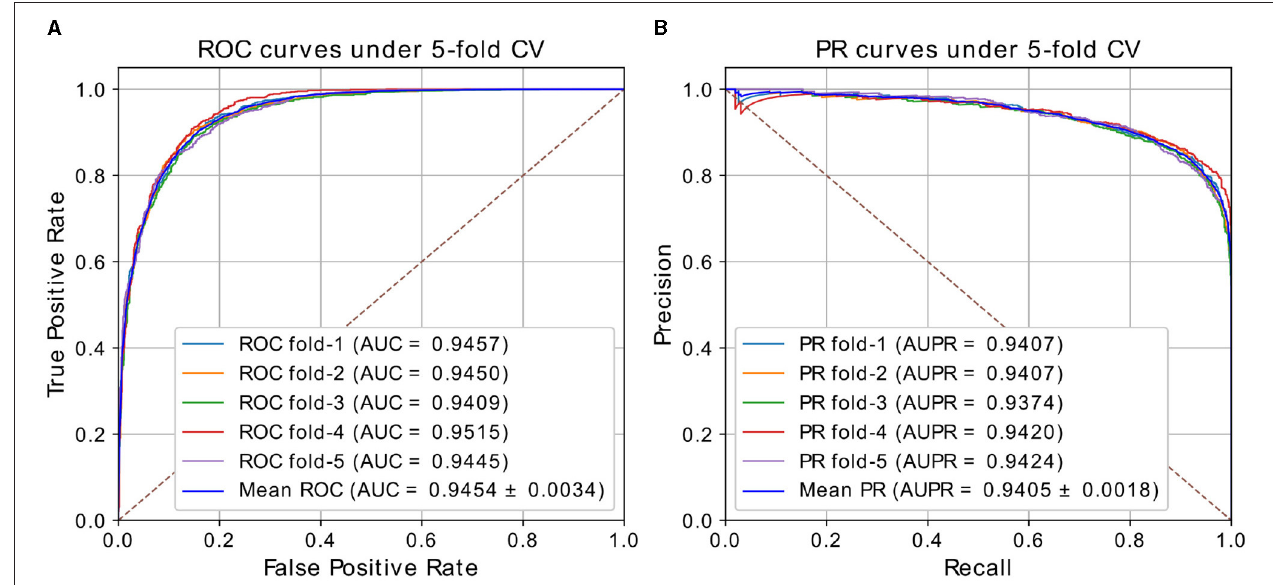
FIGURE 2 | (A) ROC curves and (B) P-R curves of HGATMDA under five-fold CV based on HMDD v2.0.